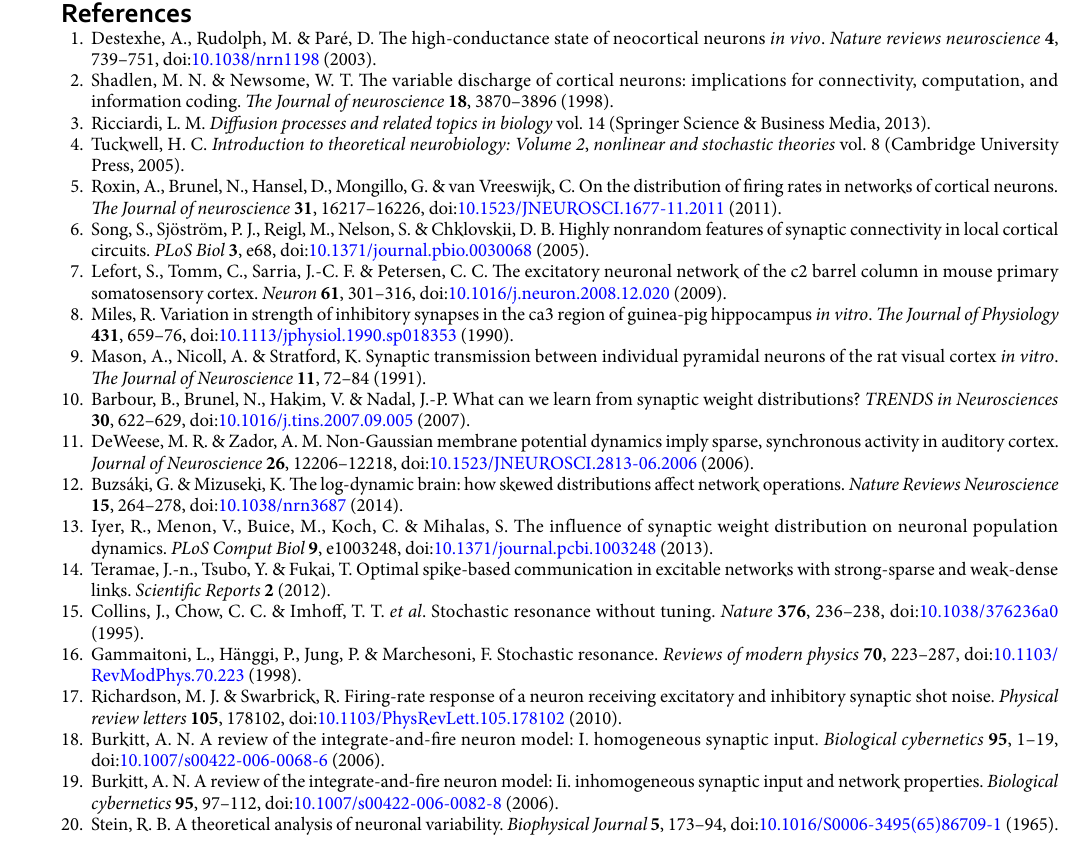
t crossover occurs for ≈ R r 2 , indicating that the firing activity of the neuron is now mainly driven by the sto- e 0 chastic component. An interesting semi-analytic approach has been recently reported for excitatory shot noise in ref. 13. However, further progresses are required to achieve exact firing time statistics going beyond the diffusion approximation for generic distributions of instantaneous excitatory PSPs, as well as for more realistic neuronal models like the Exponential Integrate and Fire (EIF) neuron 39 able to reproduce quite accurately the dynamics of cortical neu- rons 40 . In particular, as shown in the Supplementary Information, the LIF neuron response is a limit case of the EIF dynamics both within the diffusion approximation as well as for shot noise. Furthermore, the diffusion approximation fails also for the EIF to capture the neuronal firing statistics for sufficiently large IPSP amplitudes in particular at low noise intensities.